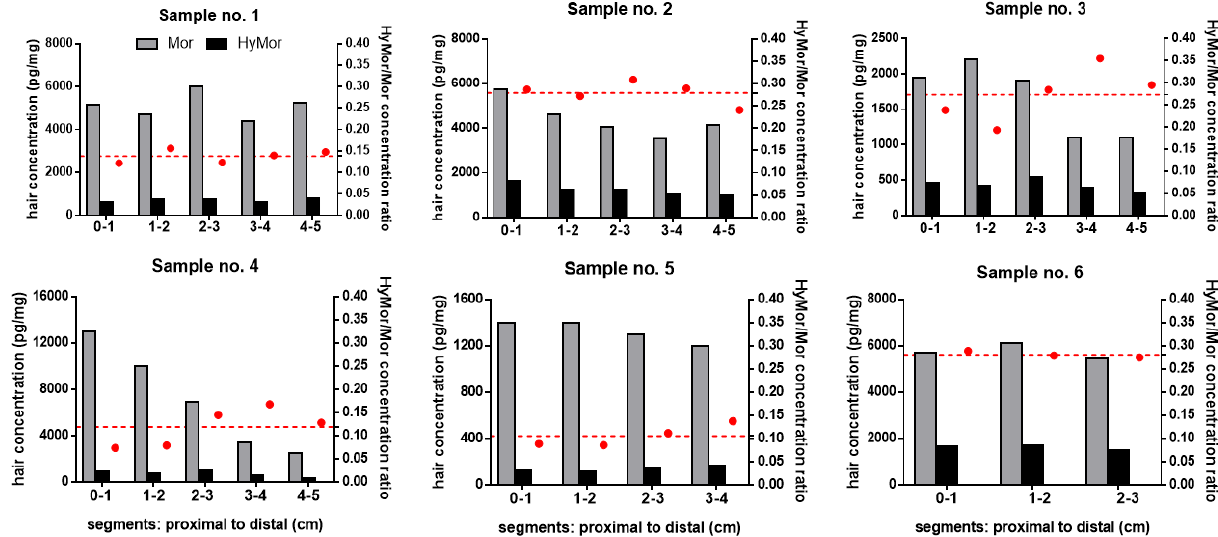
Figure 2. Morphine (Mor, grey bars) and hydromorphone (HyMor, black bars) concentrations (left y-axis) and HyMor to Mor concentration ratios (red dots; right y-axis) in the hair segments of six individuals (no. 1 to 6) with chronic Mor intake. The red dashed line represents the average of HyMor to Mor concentration ratios of the respective segments.